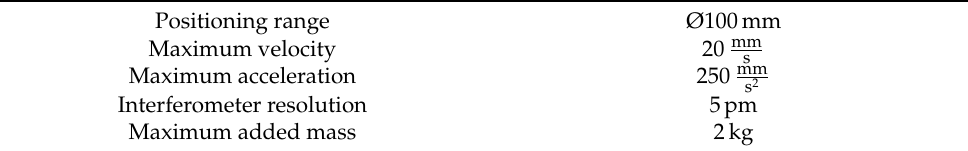
Table 1. Parameters of the positioning machine